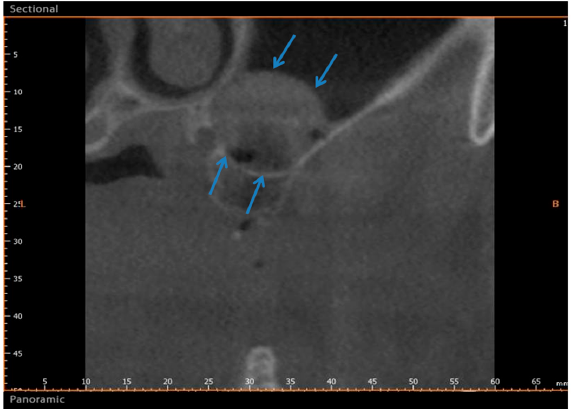
Figure 6. Group II. After six months, CBCT image showing a bone formation in the sinus (Arrows). The arrows indicate the newly formed bone between the basal bone and the upper portion of sinus.